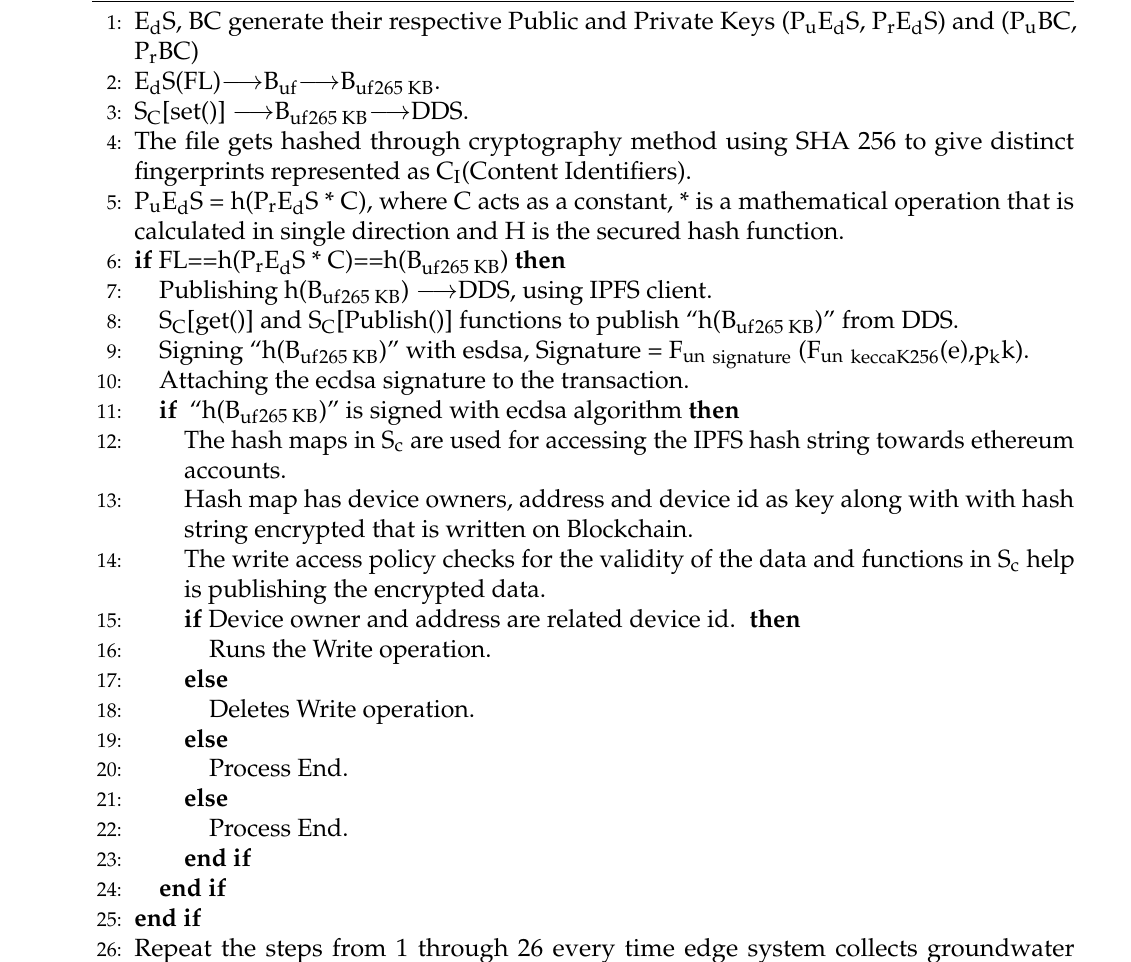
Algorithm 1 Data from Groundwater endsystems to IPFS and